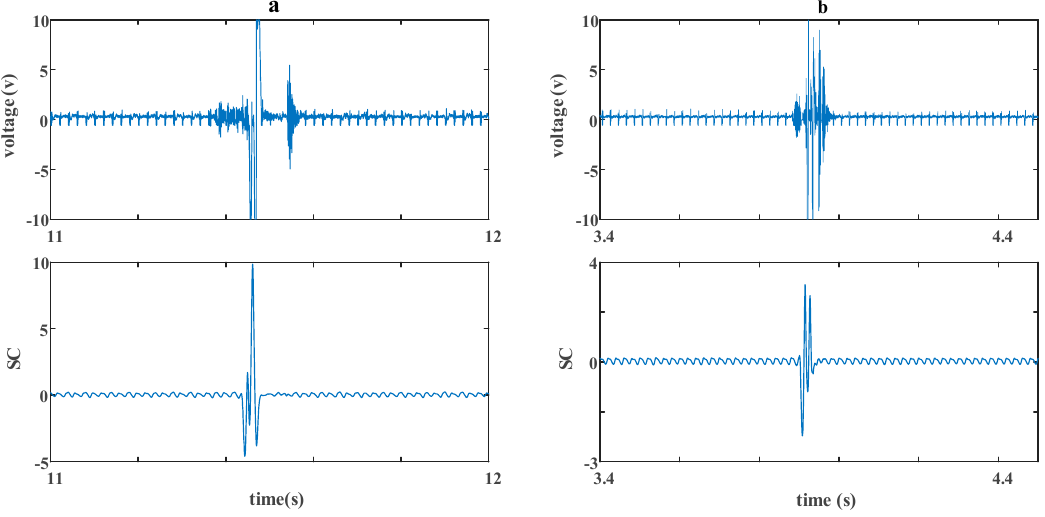
Figure 15. A detailed view of the dashed boxes in Figure 14; ( a ) a detailed view of dashed box a; ( b ) a detailed view of dashed box b.